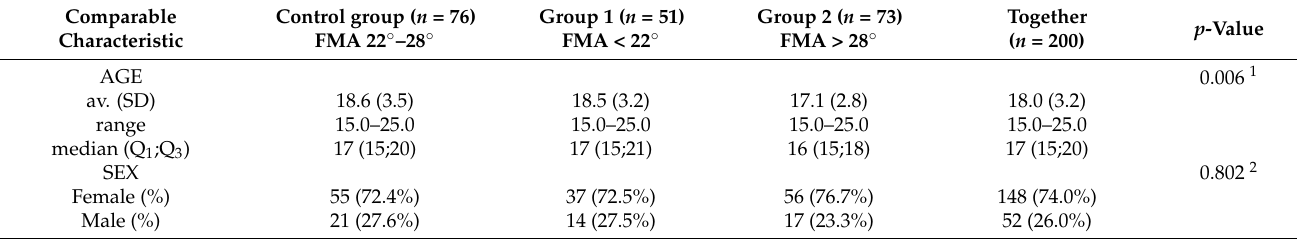
Table 3. Comparison of age and sex among the examined groups. Comparable